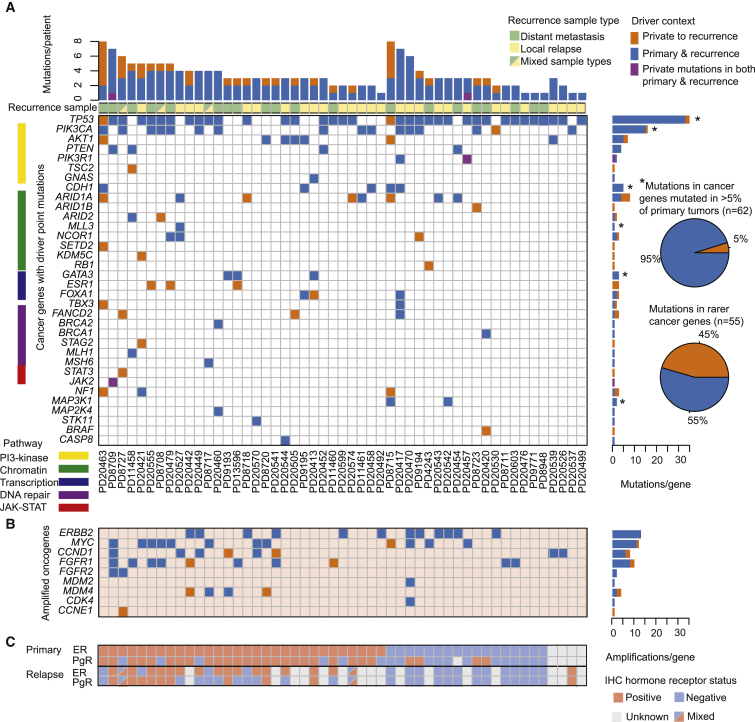
Temporal Distribution of Mutated Cancer Genes in 51 Paired Primary Tumor and Relapse Samples(A) The heatmap indicates if the driver mutation is early (blue), defined as present in both the primary tumor and recurrence, or late, being detected in the recurrence deposit(s) only (orange), or different mutations in the same gene seen in both the primary and recurrence (purple). Asterisks (∗) indicate cancer genes mutated in >5% of 705 primary tumor samples. The pie charts compare the proportion of mutations that are private to recurrence samples within most commonly mutated genes and within comparatively rare cancer genes (mutated in <5% of primary tumors). Stacked barplot above the heatmap relates cumulative incidence of point mutations and amplifications in (C) for each individual patient.(B) Temporal ordering of amplified oncogenes derived from analysis of next-generation sequencing data. Tile colors follow the format stated in (A).(C) Blue and pink tiles indicate the immunohistochemical (IHC) classification by estrogen receptor (ER) and progesterone receptor (PgR) of primary and relapse samples, where a split tile indicates multiple relapse samples with different ER/PgR statuses.See also Figures S5 and S6.